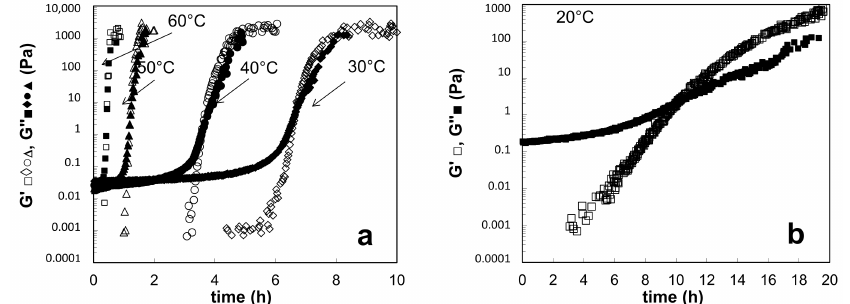
Figure 7. Dependence of dynamic moduli G (cid:48) and G (cid:48)(cid:48) on time of the WO 3 gelation process at different temperatures: ( a ) 30 ◦ C, 40 ◦ C, 50 ◦ C and ( b ) 20 ◦ C. The tests were performed in linear viscoelastic range. Solid symbols represent viscous modulus G”, hollow symbols represent elastic modulus G’.